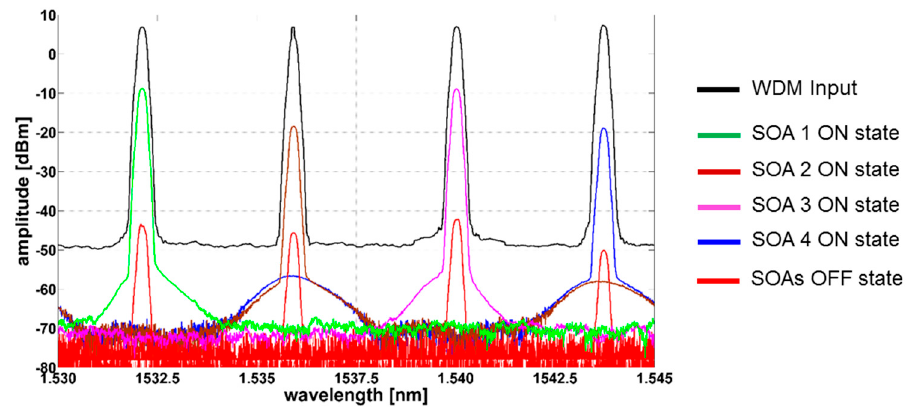
Figure 6. Optical spectra of the WDM channels switched by the Wavelength Selective Switch (WSS).